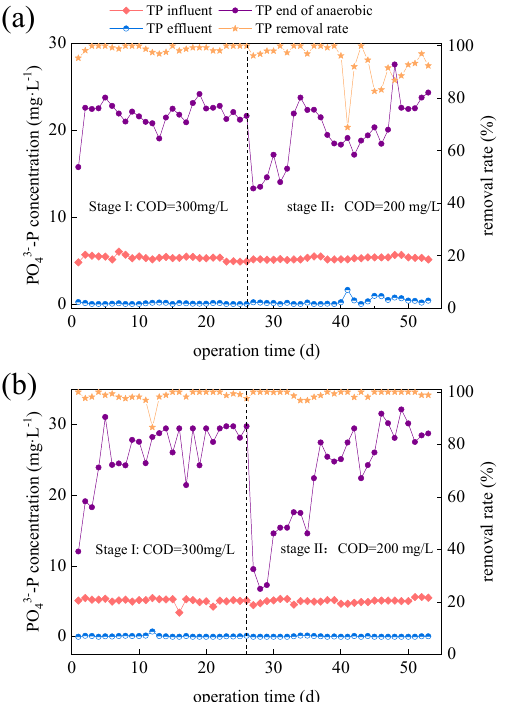
Figure 3. Removal of PO 3 + -P in a SNDPR system under different COD concentrations in influent 4 (( a ): 100 kPa, ( b ): 72